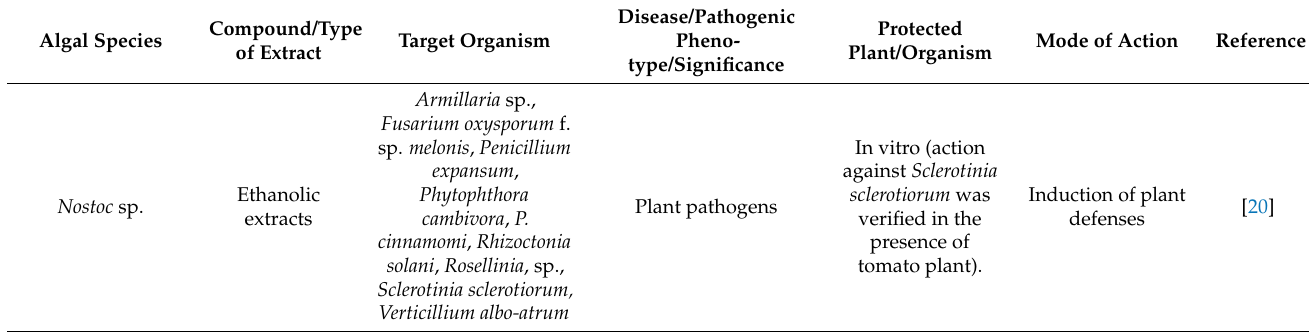
Table 3. Antifungal activity of algal extracts against known plant